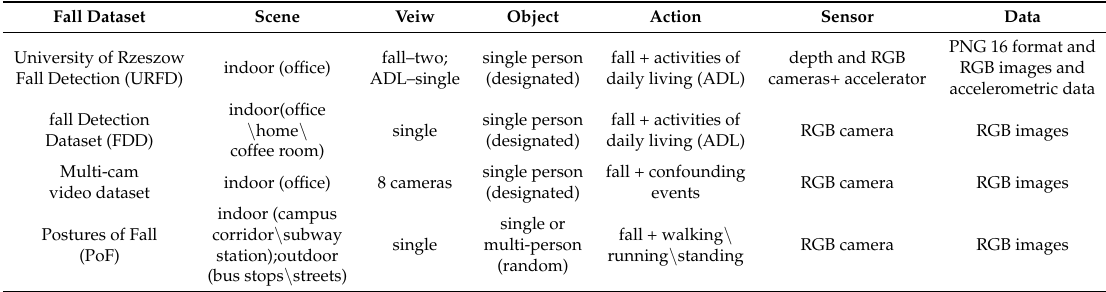
Table 3. The comparison of four